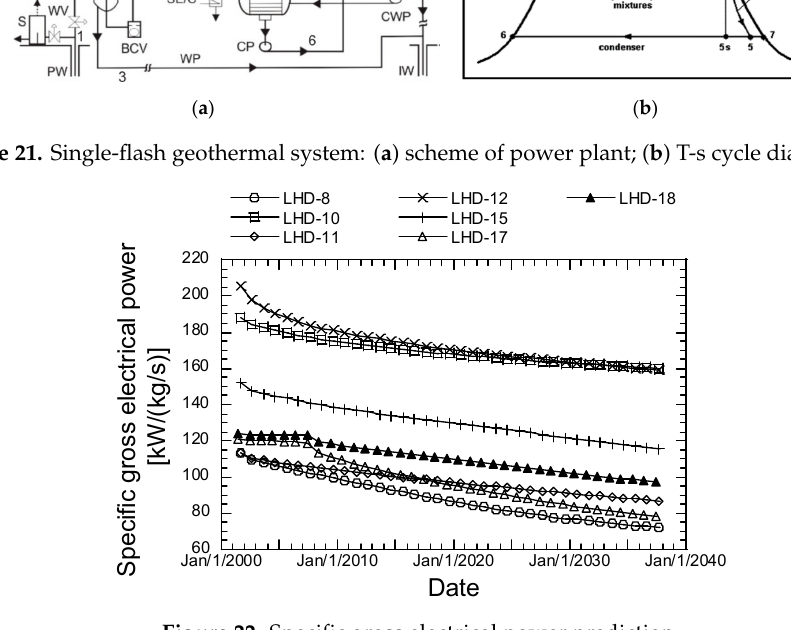
Figure 22. Specific gross electrical power prediction.